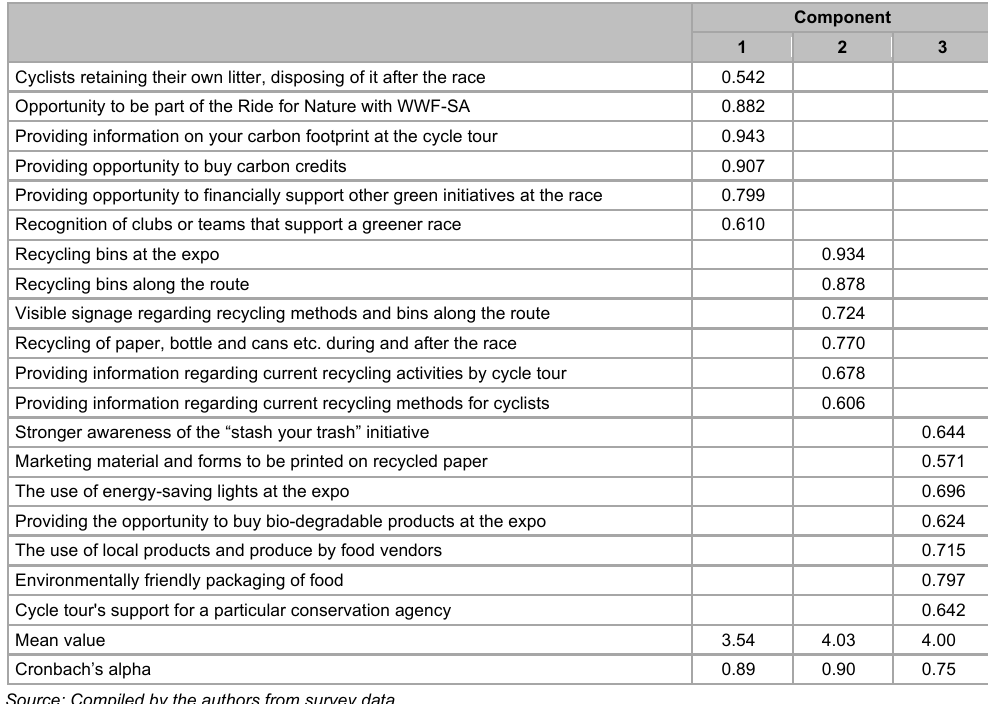
Types of cyclists by their green views